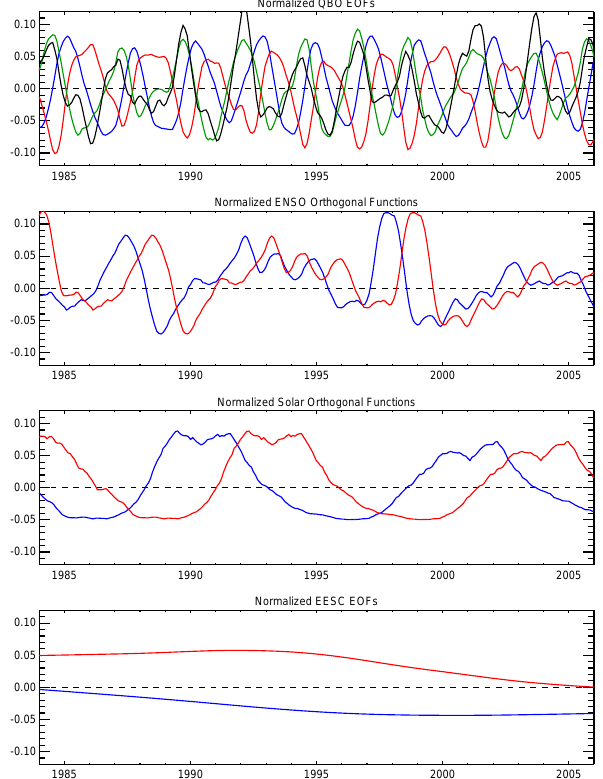
Figure 1. Orthogonal functions used for the regression. There are four QBO EOFs (blue [1], red [2], green [3], and black [4]), two time-shifted ENSO orthogonal functions (blue [1] and red [2]), two time-shifted solar orthogonal functions (blue [1] and red [2]), and two EESC EOFs (blue [1] and red [2]).